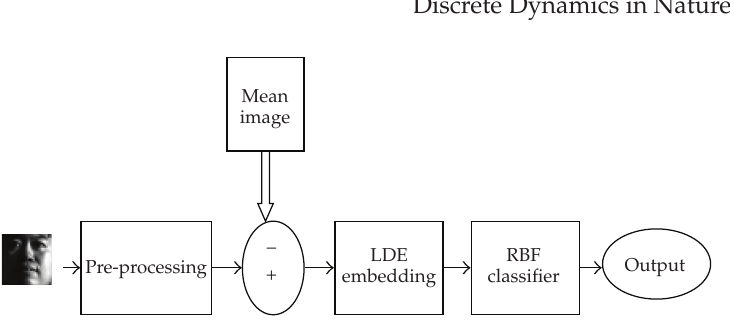
Figure 1: Block diagram of the Locally Linear Discriminate Embedding (cid:2) LLDE (cid:3)